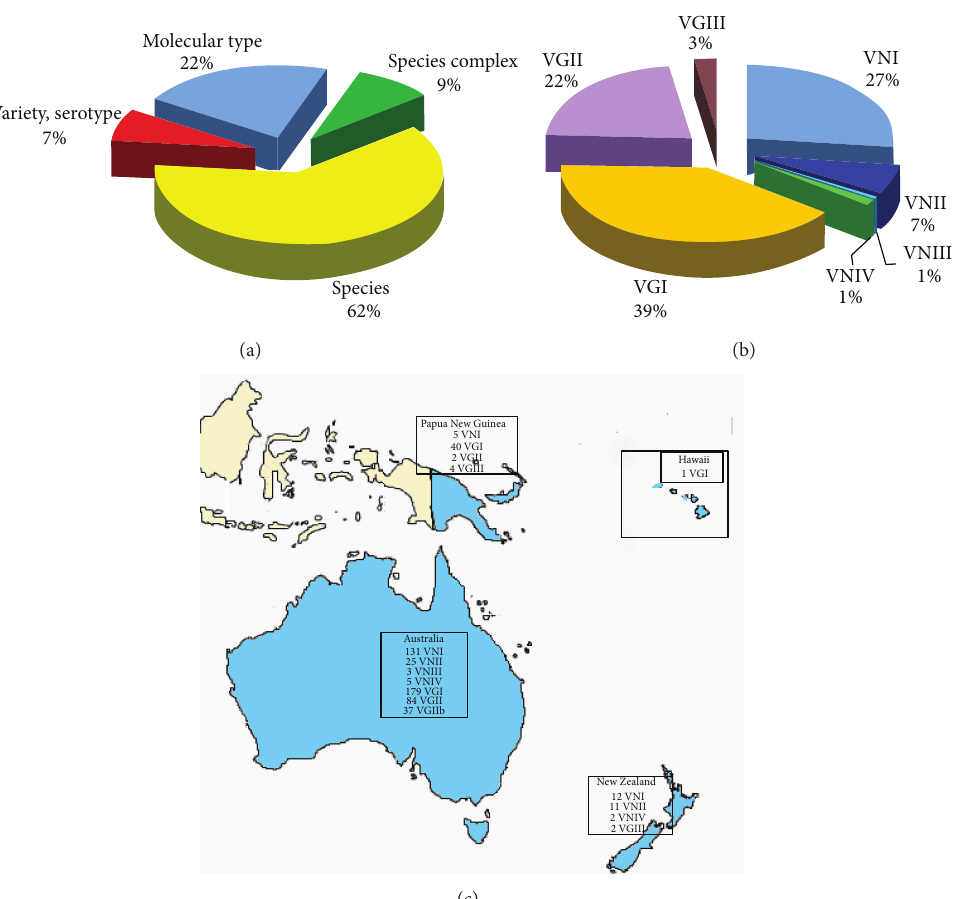
F 2: Percentage of Cryptococcus neoformans and Cryptococcus gattii isolates ( variety/serotype, or molecular type level (a). Prevalence of the different �N and �G molecular types among the isolates identi�ed at molecular type level ( ) (b). Geographic distribution of the molecular types identi�ed in �ceania (c). Molecular typing data have been 𝑛𝑛 𝑛 𝑛𝑛𝑛